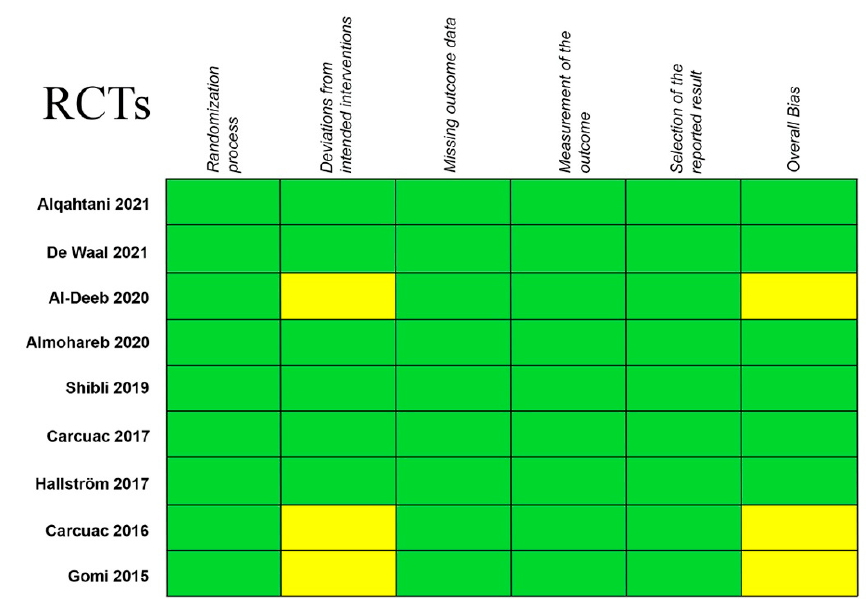
Figure 2. Quality evaluation of the RCTs using the Robins-II Tool. The risk of bias of the included studies was judged as low (green), some concerns (yellow) or high (red) [1,6,24,30,48,51,54–56].